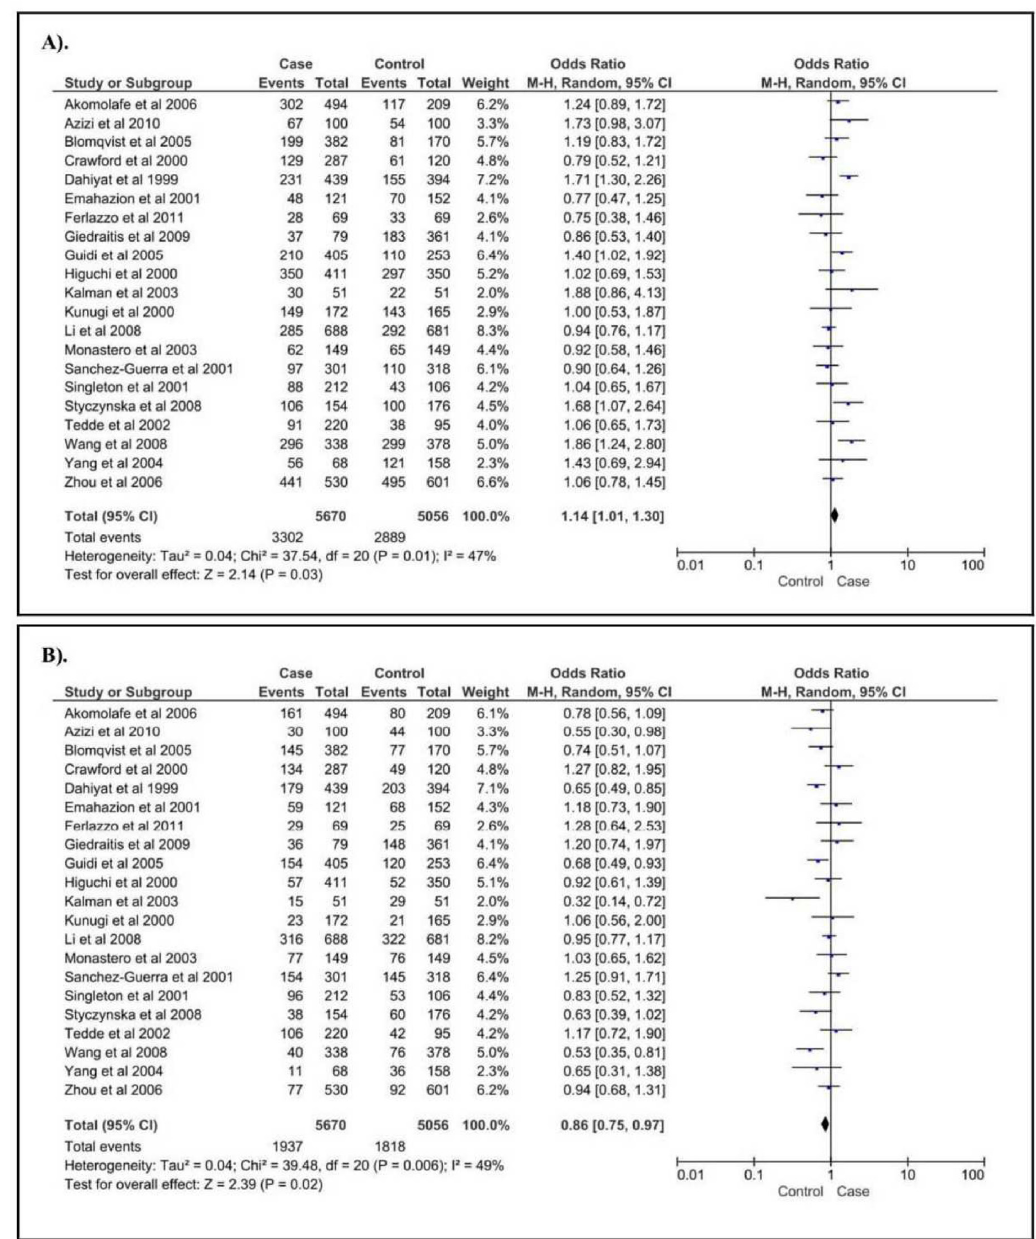
Figure 2. Forest plot of the association between NOS3 G894T gene polymorphism and the risk of age-related cognitive impairment. ( A ). GG vs. GT+TT; ( B ). GT vs. GG+TT.